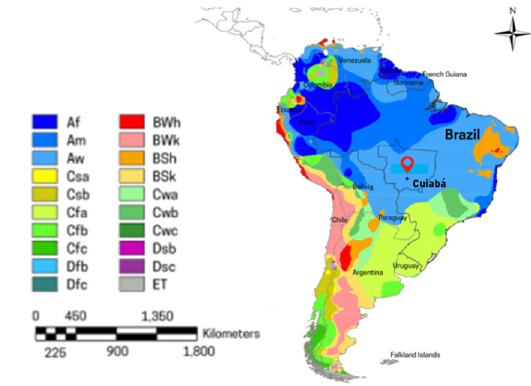
Figure 1. Location of the city of Cuiabá in South America. Source: adapted from Peel et al. [9].